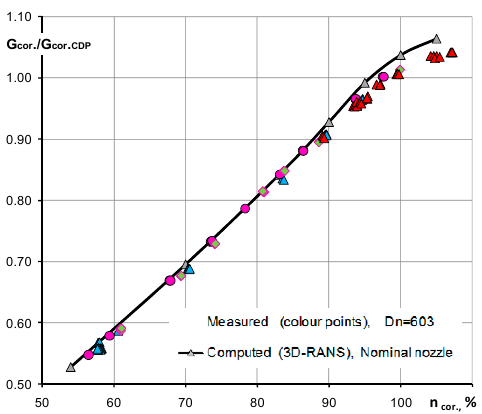
Figure 11. Comparison of calculated and experimental η * ad / η * ad CDP values along operating line at CDP, n cor = 95%.